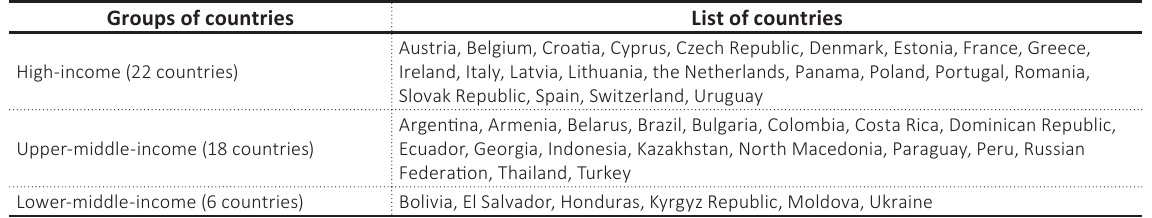
Table А1. The list of countries in the panel Groups of countries